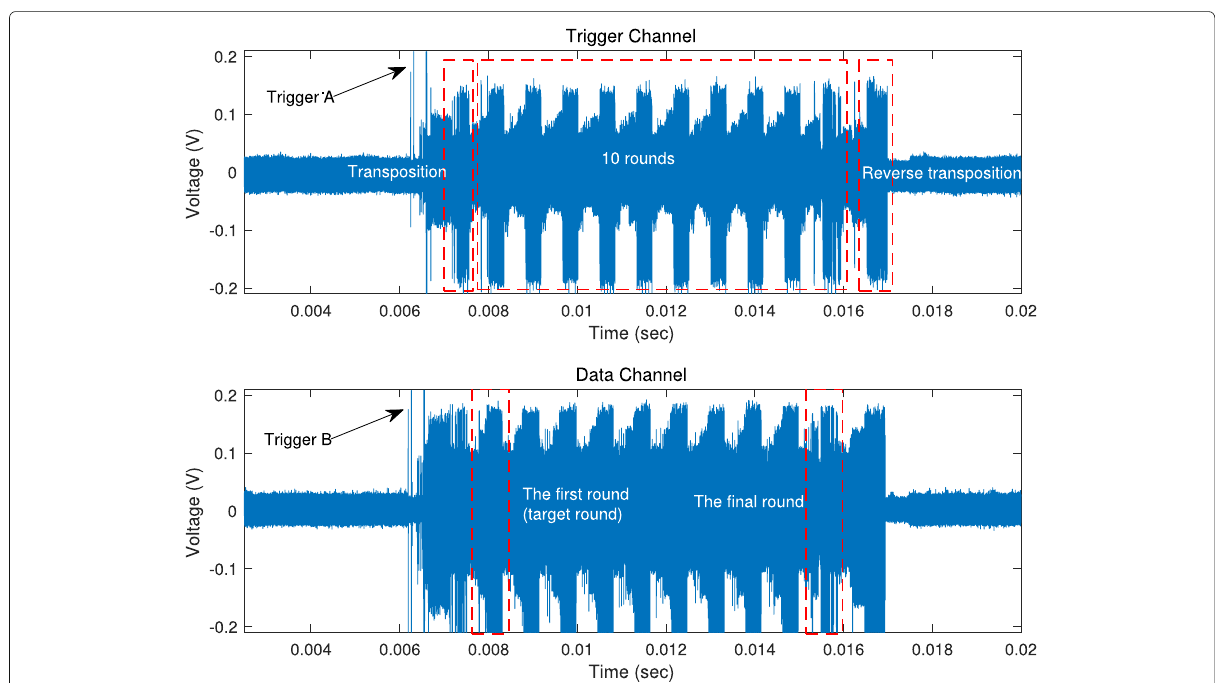
Fig. 2 Overall EM measurement of our GPU-based bitsliced AES implementation